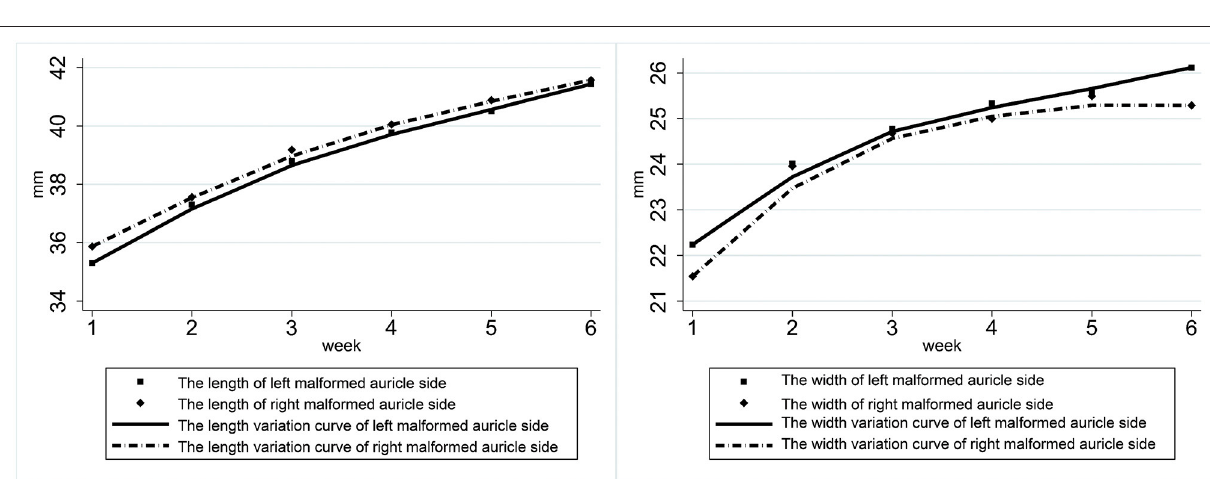
FIGURE 3 | Variation in the length and width of the ears of patients with bilateral ear